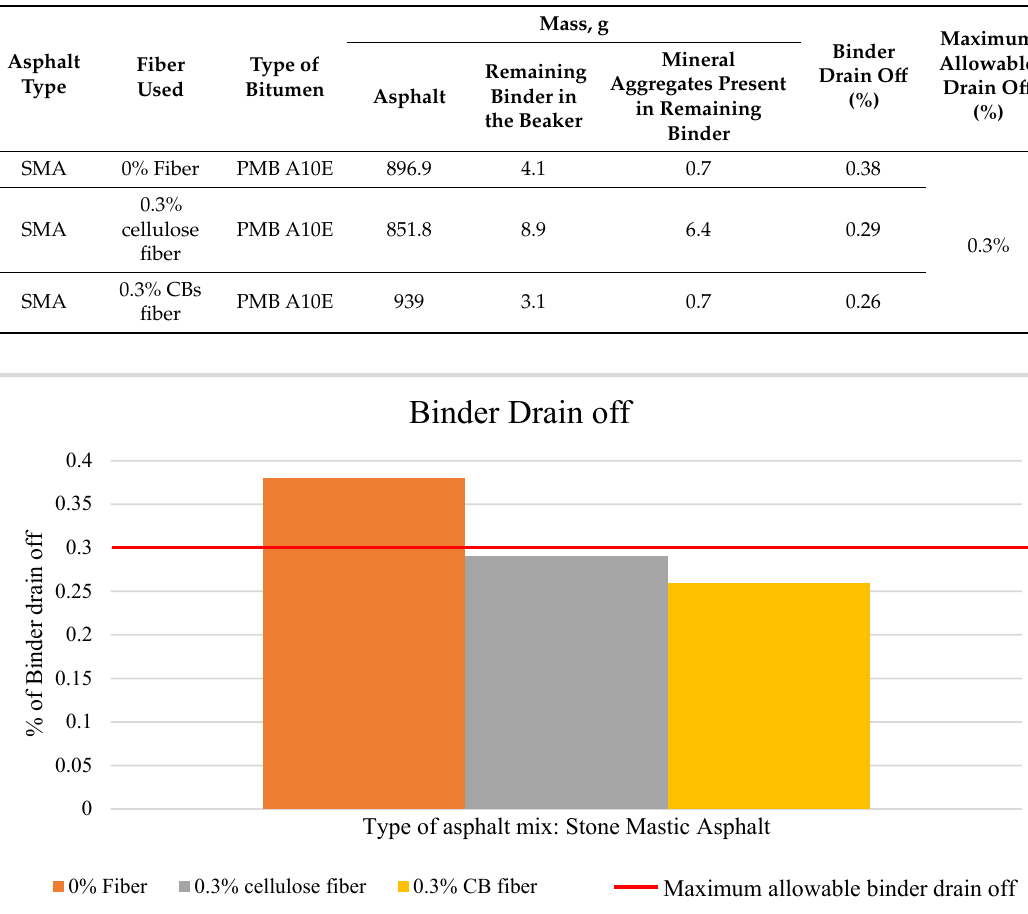
Figure 17. Relative view of ‘Binder drain off’ of asphalt mixture prepared with bitumen modified with different types of fiber.